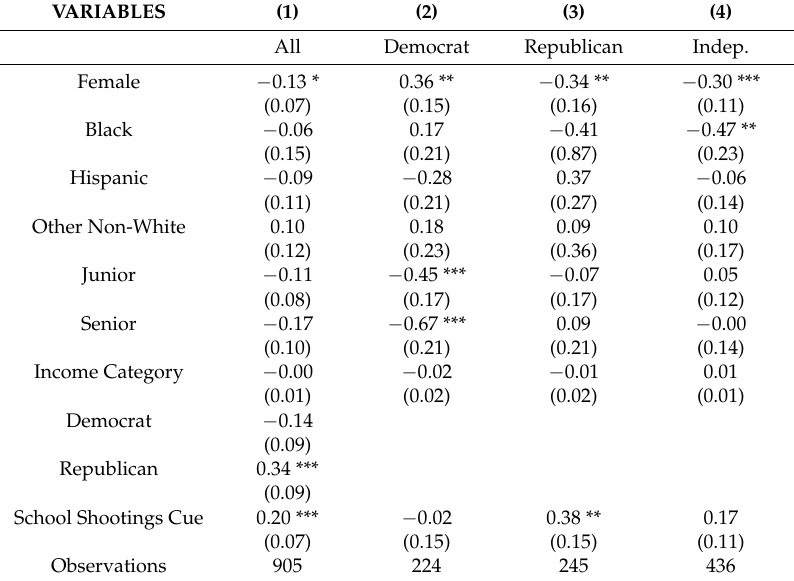
Table 2. Emotional cues and attitudes towards arming school employees. Ordered probits: dependent variable is degree of agreement with the statement that “schools that have properly trained and armed nonteaching staff would become safer